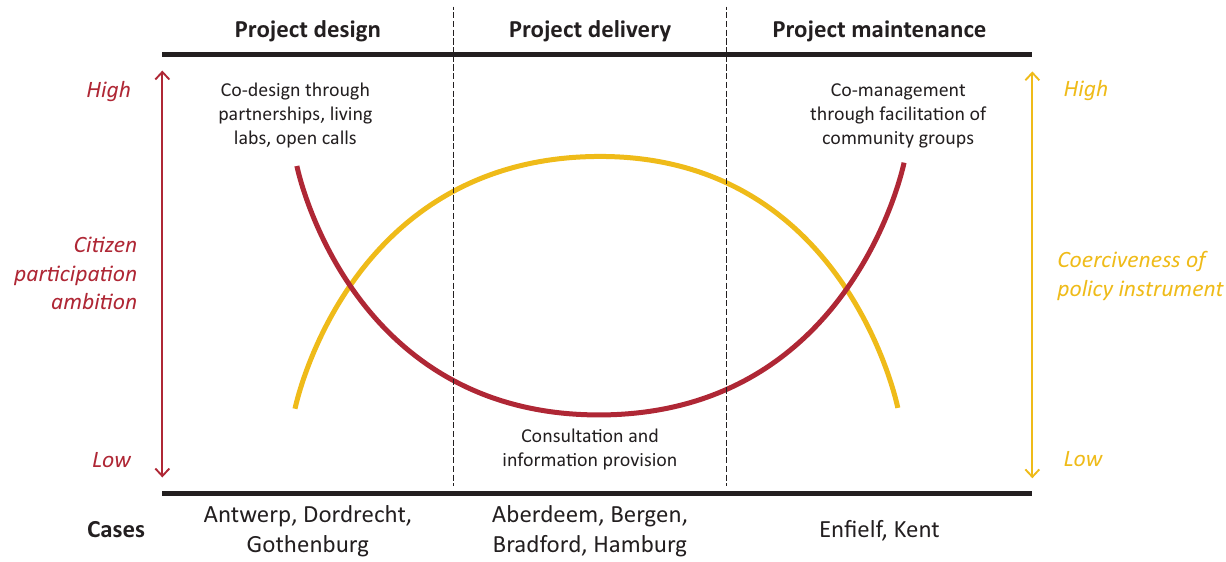
Figure 1. Citizen participation in the three green infrastructure project phases, including examples of policy instru- ments